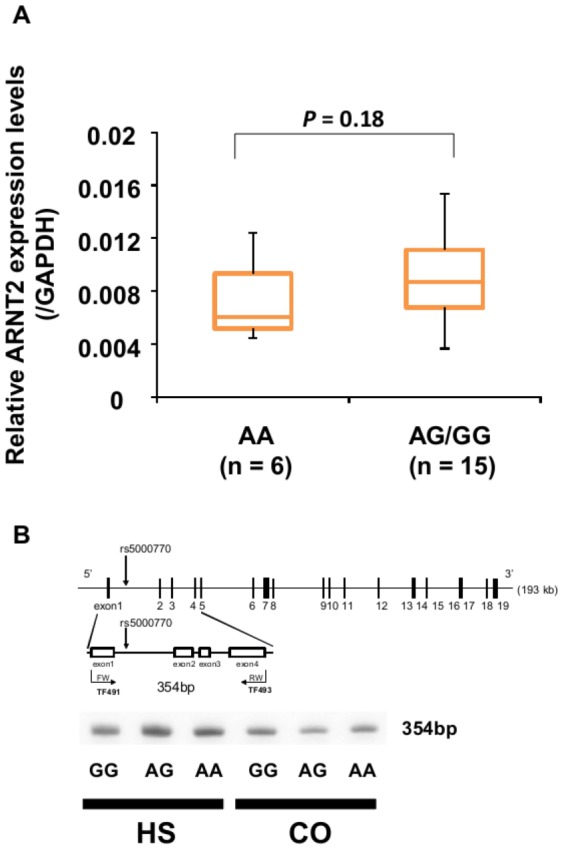
Association between rs5000770 genotype and ARNT2 expression.(A) Boxplot of the ARNT2 mRNA level in hFFCs from child HS patients with different genotypes (6 AA and 15 AG/GG) relative to GAPDH measured using TaqMan® real-time PCR. Statistical significance was evaluated by the Mann-Whitney U test. (B) Scheme of the quantitative PCR strategy for screening splicing variants. No splicing variant was detected using intron-spanning RT-PCR in hFFCs either from HS or CO patients.